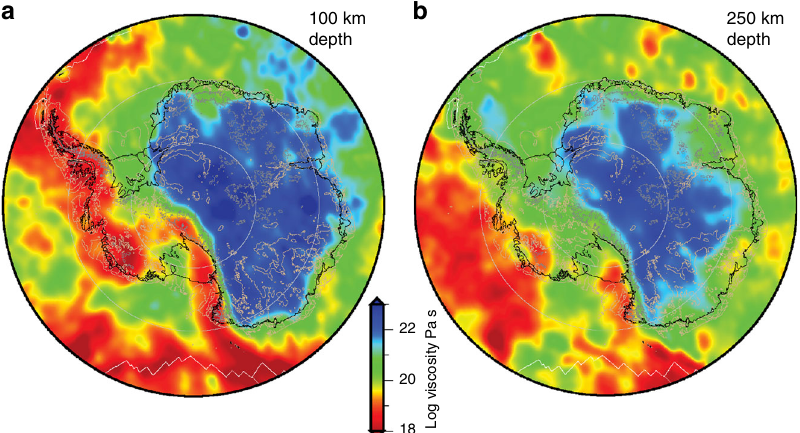
Fig. 4 Spatial variations in estimated upper mantle viscosity beneath Antarctica at depths of ( a ) 100 km and ( b ) 250 km. Viscosity is estimated using the seismic shear velocity model presented in Fig. 3 and the method outlined in Wu et al. 65 , as discussed in the text. These results are derived using a dry diffusion creep rheology 62 and the IJ05-R2 (ref. 30 ) reference viscosity model, assuming that the seismic velocity variations are entirely due to temperature, except that a correction for depleted cratonic mantle is applied to the East Antarctic